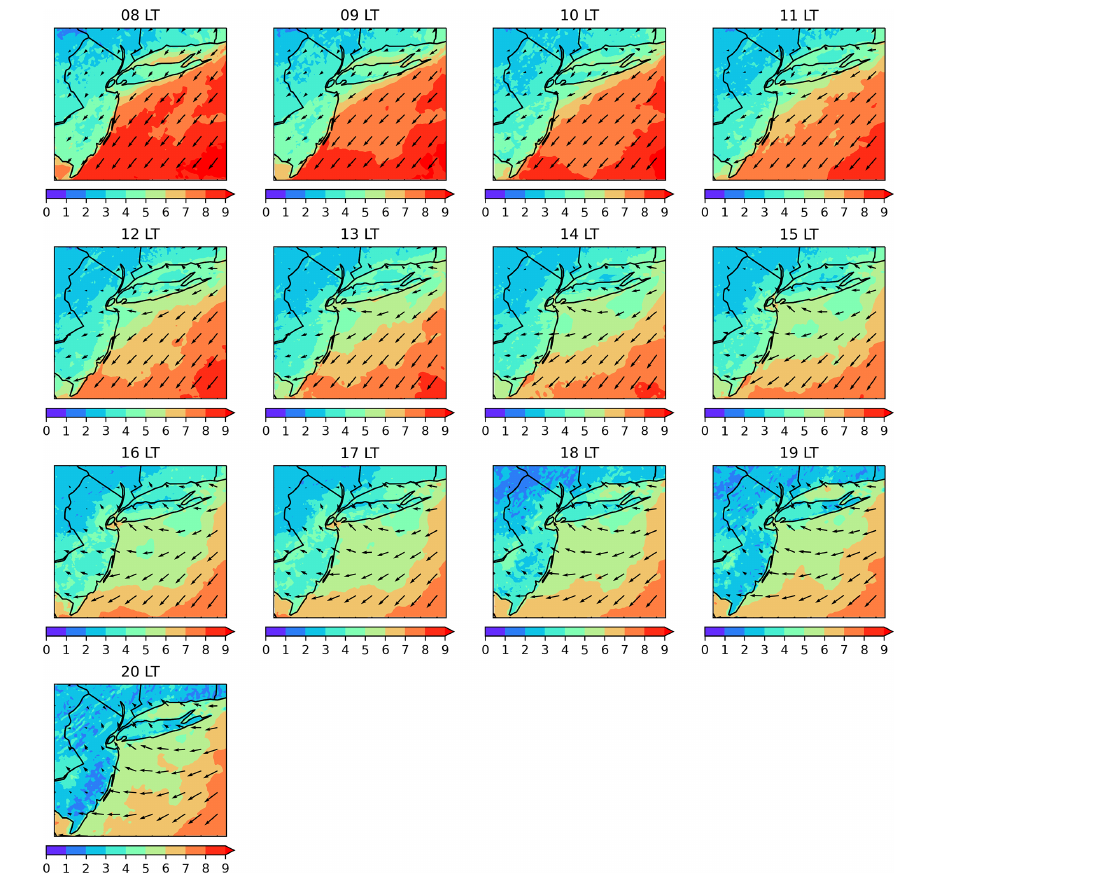
Figure 8. Similar to Fig. 6 but for the averaged backdoor sea breeze events. Table 5. Standard deviation of WS10 and WD10 of the simulated backdoor sea breeze